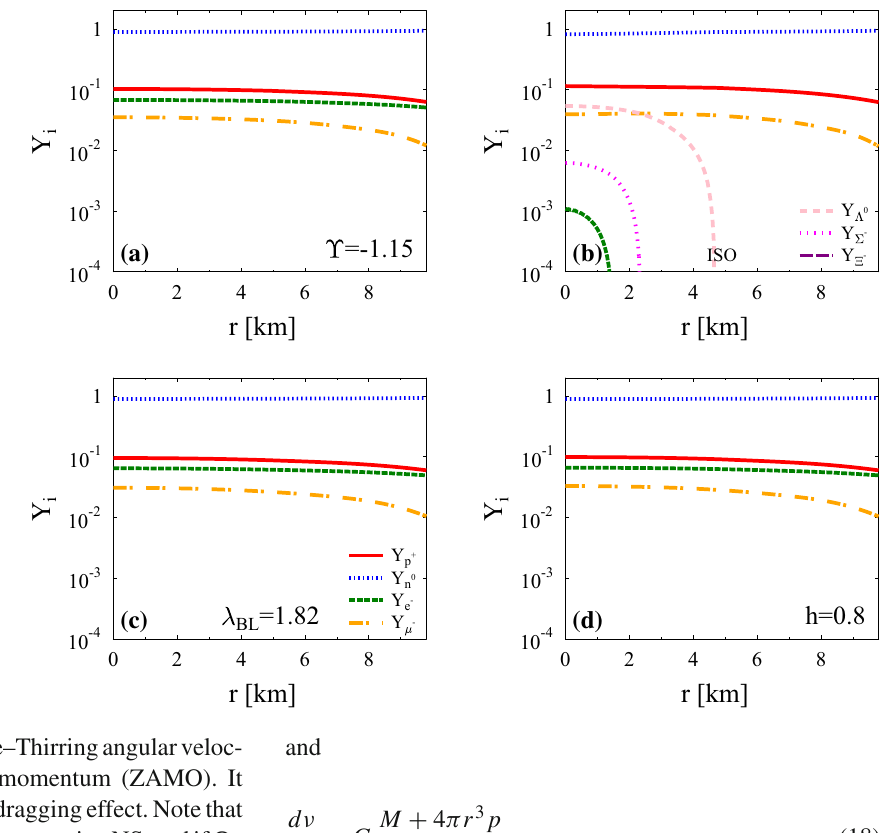
Fig. 4 Impact of anisotropic pressure on constituent composition profiles for 1.4 M (cid:3) NS with hyperons. a For DY anisotropic model, b for the isotropic case, c for BL anisotropic model, and d for HB anisotropic